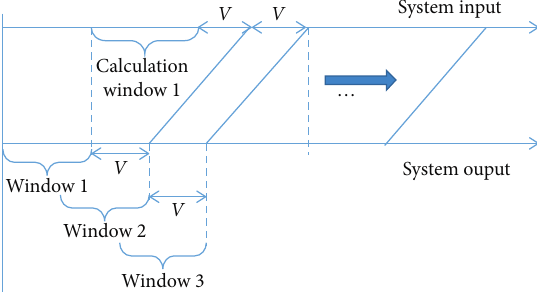
Figure 3: Schematic diagram of step